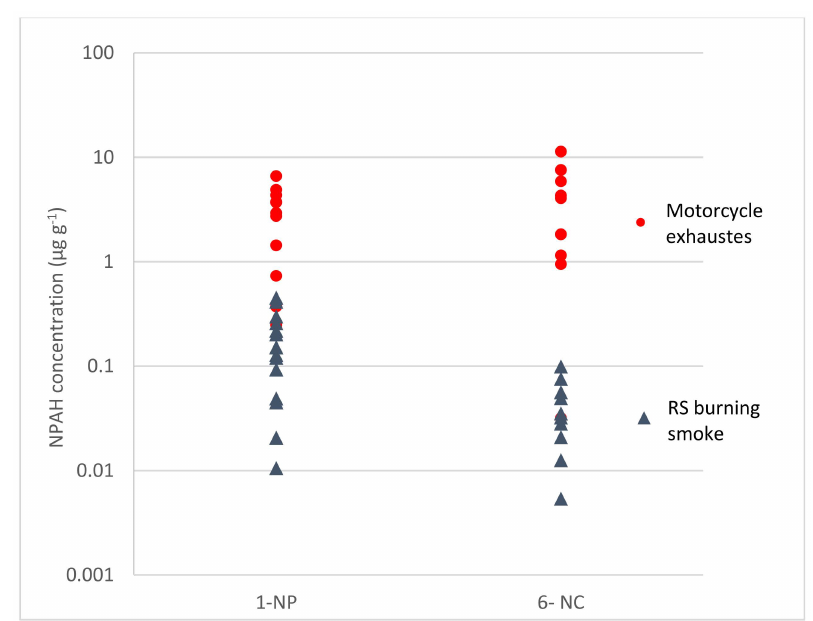
Figure 7. Comparison of NPAH levels 1 in TSP between rice straw burning smoke and motorcycle exhausts. 1 The level of individual NPAH in TSP was showed in µ g g − 1 . RS burning smoke (n = 14); motorcycle exhausts (n =